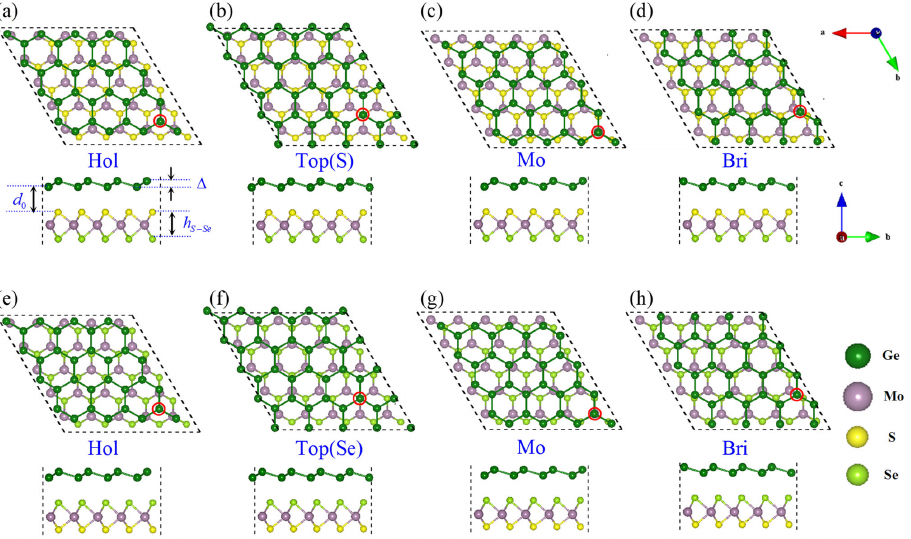
Figure 1. Top and side views of representative configurations of Ge/SMoSe ( a – d ) and Ge/SeMoS ( e – h ) heterostructures. The interlayer d 0 , buckling height of germanene ∆ , and height of the MoSSe layer h S − Se are labeled as an example in ( a ). Table 1. Calculated binding energies E b , lattice constant a 0 , interlayer distance d 0 , buckling height